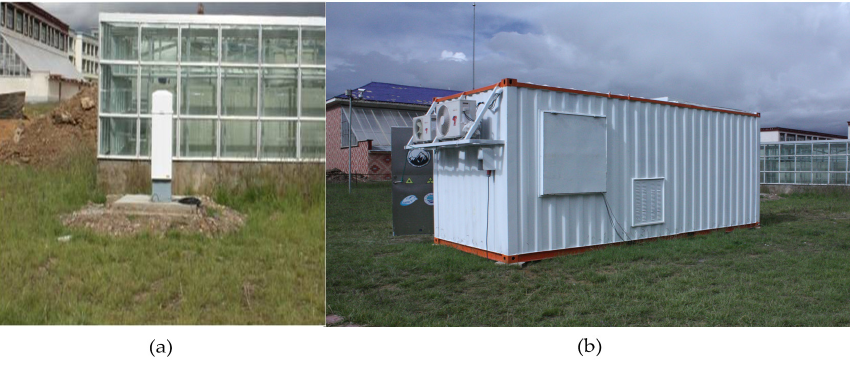
Figure 2. Pictures of: ( a ) CL31; and ( b ) WACAL. Table 1. Component parameters of the WACAL system and CL31.